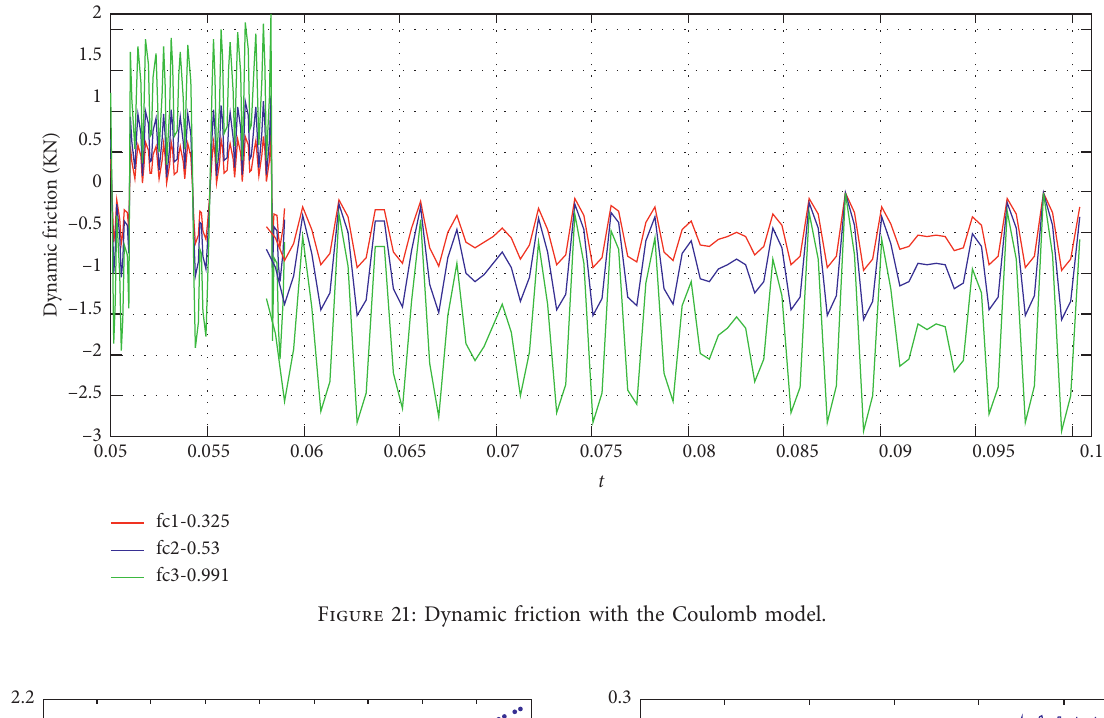
� 0 . 32. (b) Maximum Lyapunov exponent with k w